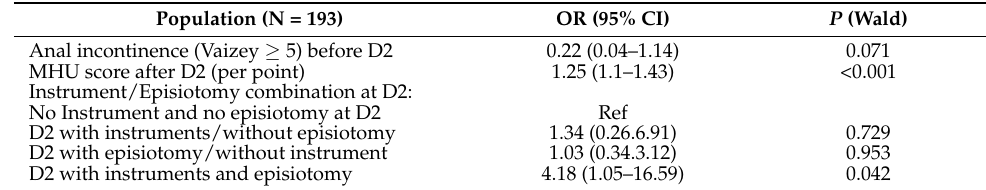
Table 7. Factors associated with a worsening of the Vaizey score ≥ 2 points after the second delivery in the subgroup of women delivering vaginally (Multivariate